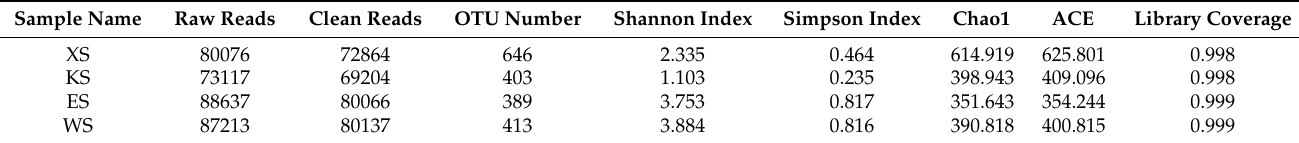
Table 1. Information on the high-throughput sequencing libraries of the bacterial 16S rRNA genes in cheese samples from Inner Mongolia.